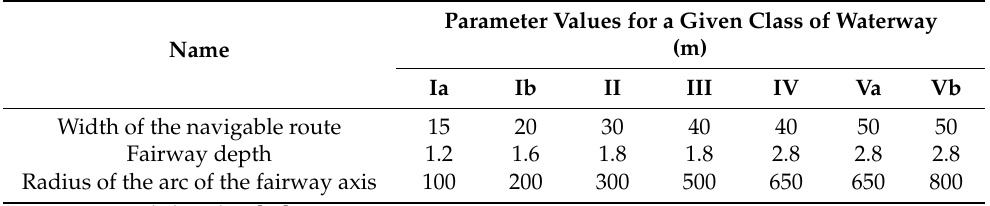
Table 1. Operating parameters of the navigable route on the river. Parameter Values for a Given Class of Waterway Name